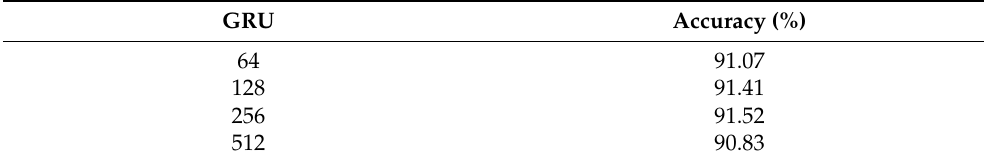
Table 3. The experimental results of different GRUs (optimizer = Nadam, learning rate = 0.00001).